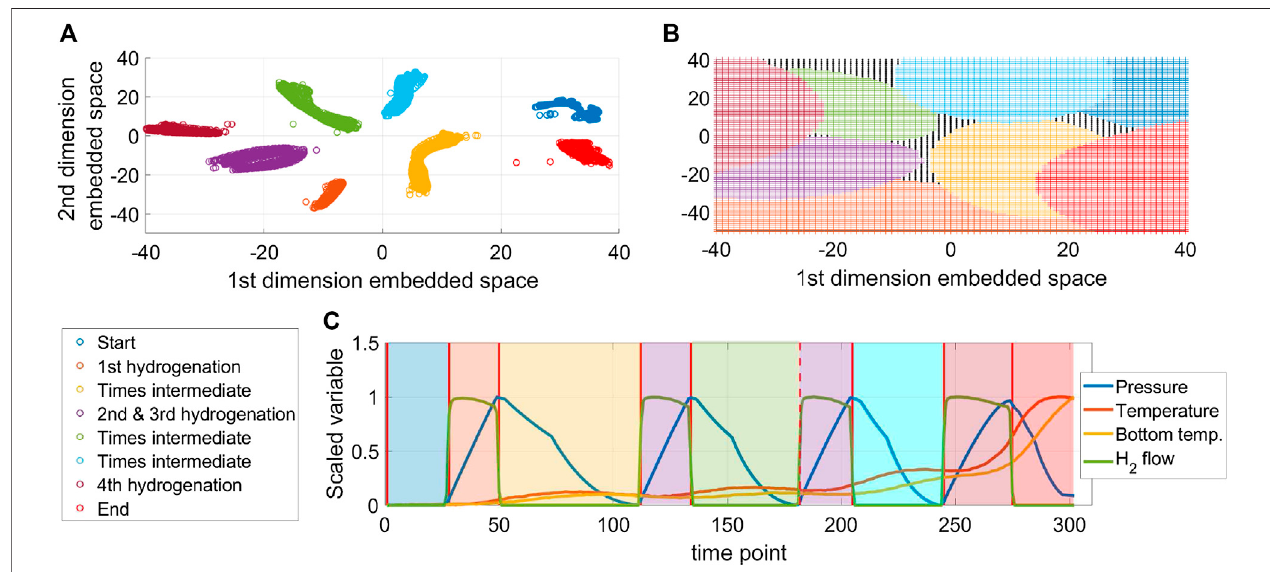
FIGURE 13 | Results on the phase identi fi cation for an hydrogenation